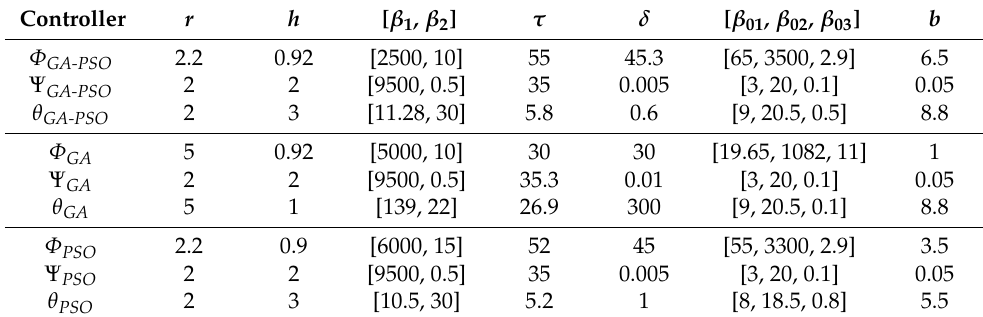
Table 4. Control Parameters optimized with GA-PSO, GA and PSO.